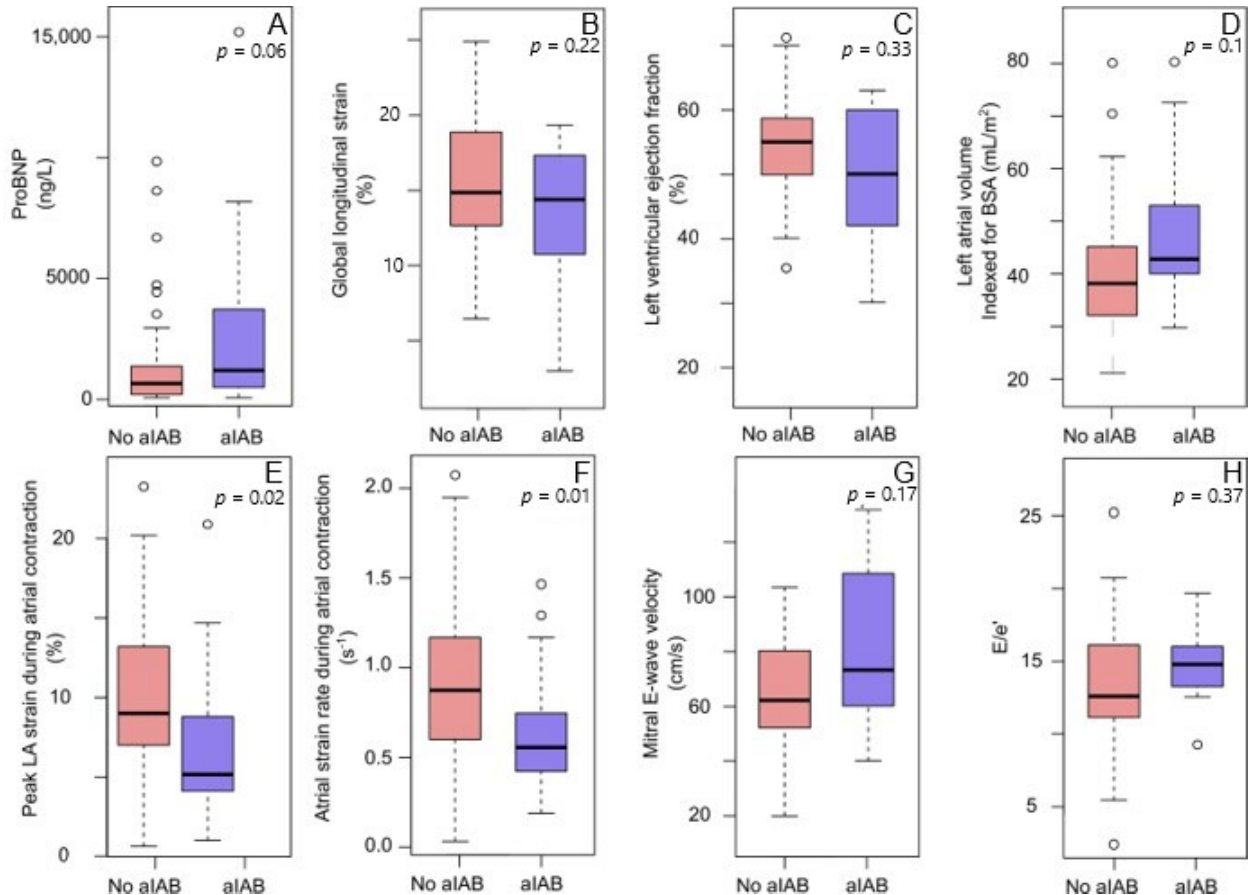
Figure 3. Biomarker and echocardiographic measures in patients with and without advanced interatrial block (aIAB). Patients without aIAB are presented in red bars and patients with aIAB in blue bars. Upper panel: ( A ) N-terminal pro b-type natriuretic peptide (proBNP); ( B ) global longitudinal strain; ( C ) left ventricular ejection fraction; ( D ) left atrial volume indexed for body surface area (BSA); ( E ) peak left atrial (LA) strain during atrial contraction; ( F ) atrial strain rate during atrial contraction; ( G ) mitral E-wave velocity; ( H ) E/e’. Peak left atrial longitudinal strain ( E ) and atrial strain rate ( F ) were significantly reduced in patients with advanced interatrial block.